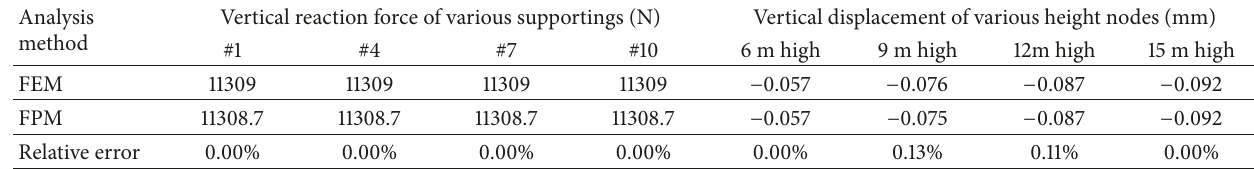
Table 1: Vertical reaction force of supportings and vertical displacement of nodes under earthquake action.